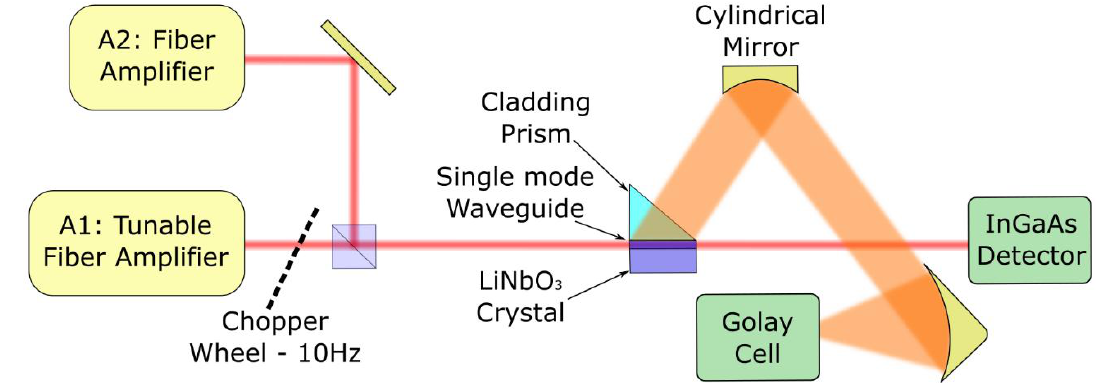
Figure 2. Schematic of the experimental setup for waveguided CW THz DFG.